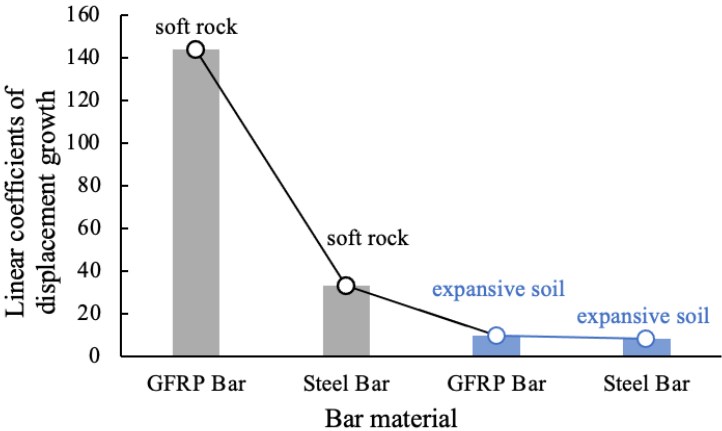
Figure 12. Gradients of displacement curve of anchorage section